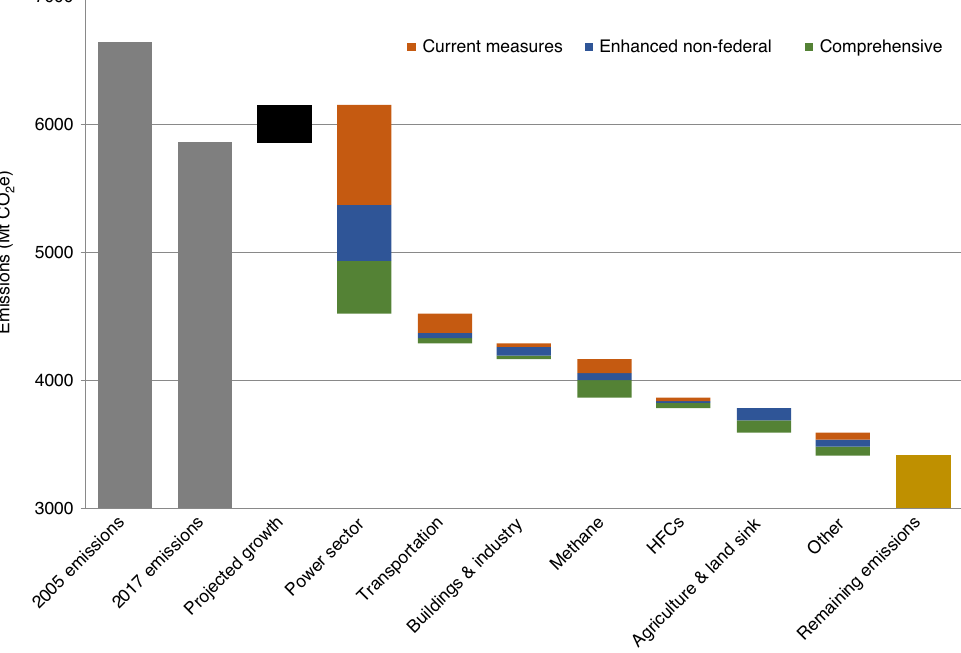
Fig. 3 Sectoral breakdown of 2030 emission reductions in three scenarios. Much of the near-term impact is realized through power sector decarbonization, primarily via renewables expansion and rapid coal reduction consistent with recent trends. Many building sector and transportation measures are re fl ected in the power sector emissions reductions. Note: Scale does not go to zero.